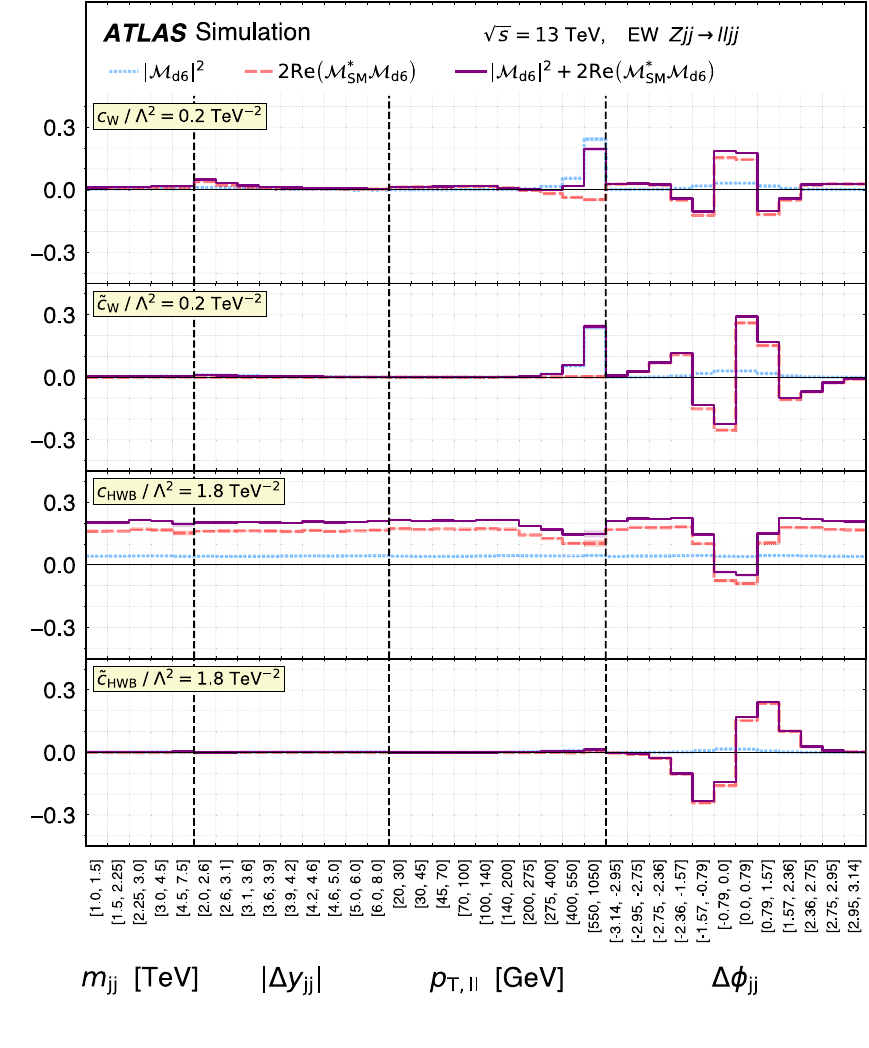
Fig. 10 Impact of the O W , ˜ O ˜ O O W , HWB and HWB operators on the EW Zjj differential cross-sections. The expected contributions from the pure dimension-six term ( | M d6 | 2 ) and from the interference between the SM and dimension-six amplitudes ) ) are shown M (2Re ( M ∗ d6 SM relative to the pure-SM prediction and represented as dotted and dashed lines, respectively. The total contribution to the EW Zjj cross-section is shown as a solid